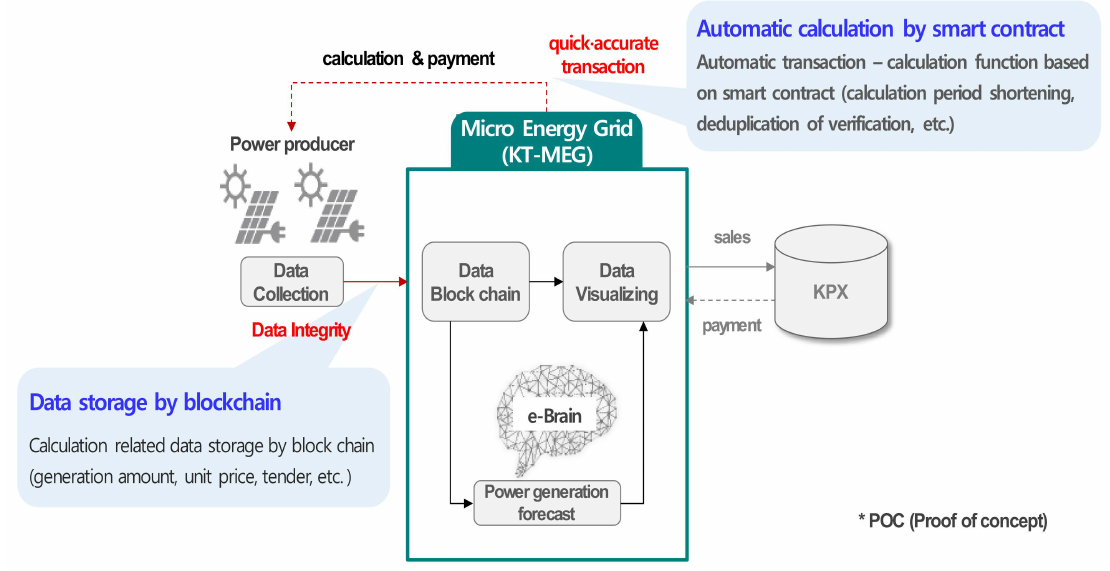
Figure 12. Conceptual diagram of blockchain-based brokerage transaction